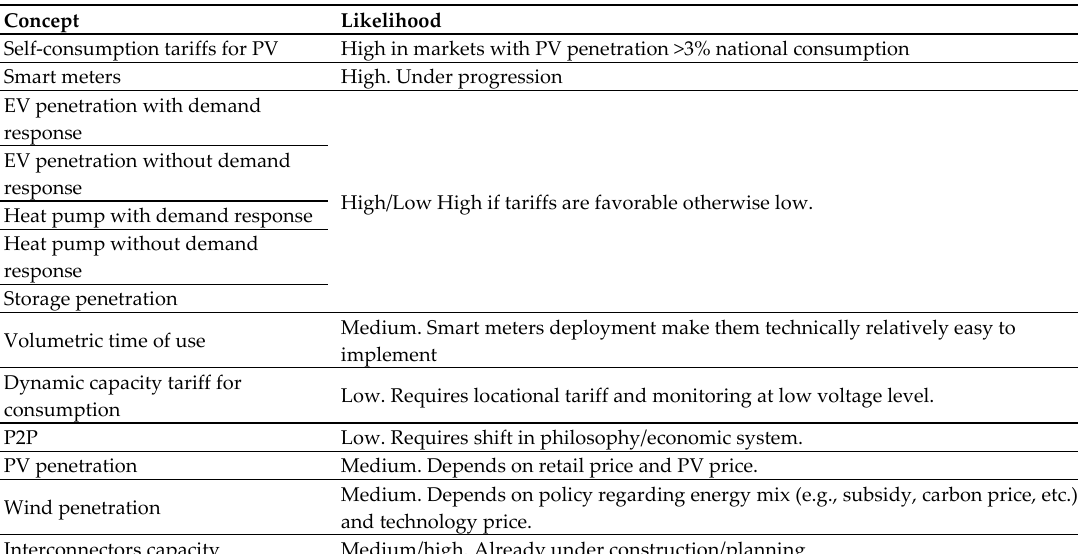
Table 1. Likelihood of tariffs evolving under various distributed energy resources (DER)